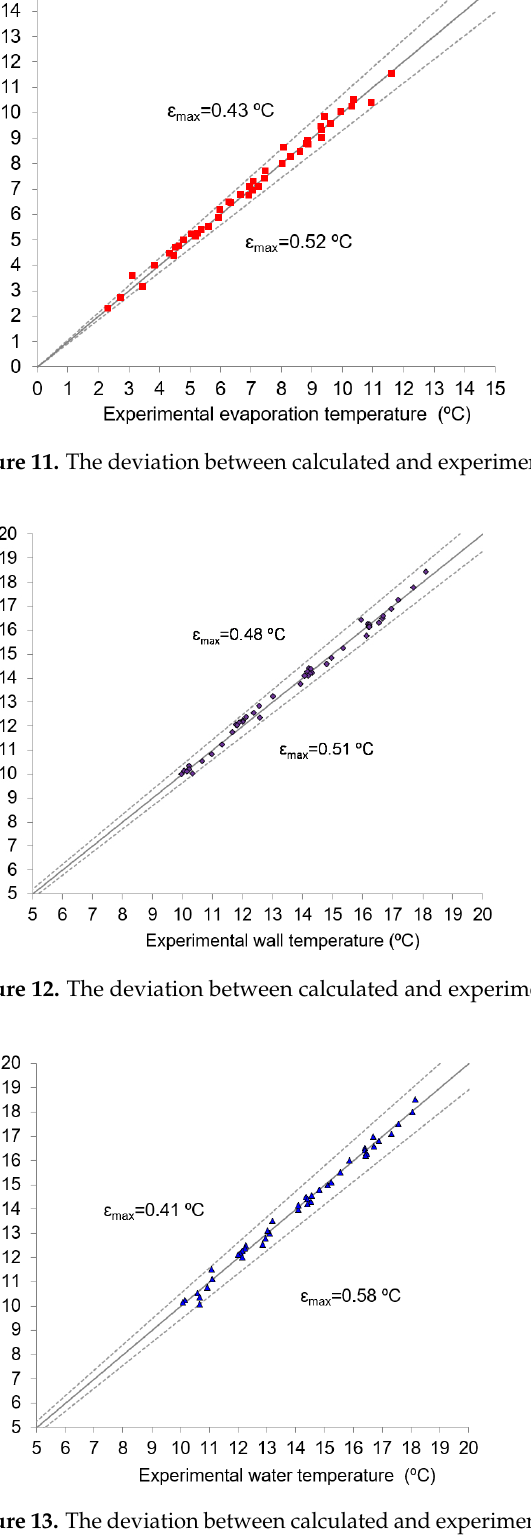
Figure 14. The deviation between calculated and experimental values of the cooling capacity. Belman, et al. [7] compare predicted and measured values for the refrigerant R134a. The predicted temperature of the water-glycol mixture at the evaporator outlet has a max- imum error of ±0.5 K. Relative error predictions for cooling capacity are approximately ±5%. Prediction of refrigerant mass flow rate ±5%. For evaporating pressure, the predic- tion error is within ±5%. Navarro- Esbría et al. [16] tested the shell -and-tube evaporator experimentally and compared the results with correlations from the literature. They also chose R134a as the working fluid. The thermal analysis of the heat exchange was based on th e ε -NTU method. The evaporator was modeled as a counter-flow heat exchanger. Among others, they also use the Kandlikar correlation, which achieves the highest accuracy and the low- est absolute mean error. The deviation between calculated and experimental values of cooling capacity was ±5%. The output parameter with the largest deviations between the predicted and experimental data is the evaporating pressure with 93.94% of the data points below 10%. The deviation for vapor pressure was 4.87%, for refrigerant outlet tem- perature ±1%, and for secondary liquid outlet temperature 0.03%. Santos et al. [22] proposed a simplified physical model that assumes a constant heat exchange coefficient and pressure drop of the evaporator. This model is used to simulate and optimize the operation of the chiller. The rigorous model shows that large variations of the order of 10% are observed in the prediction of the global heat exchange coefficient of the evaporator.